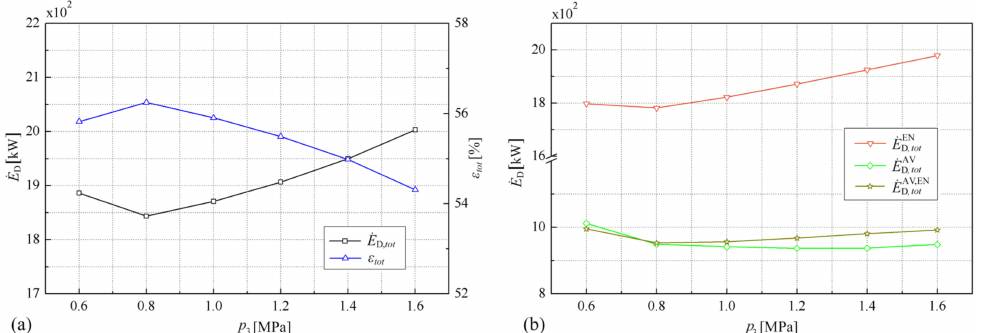
Figure 8. E ff ects of compressor inlet pressure: ( a ) conventional exergy analysis results; ( b ) advanced exergy analysis results.